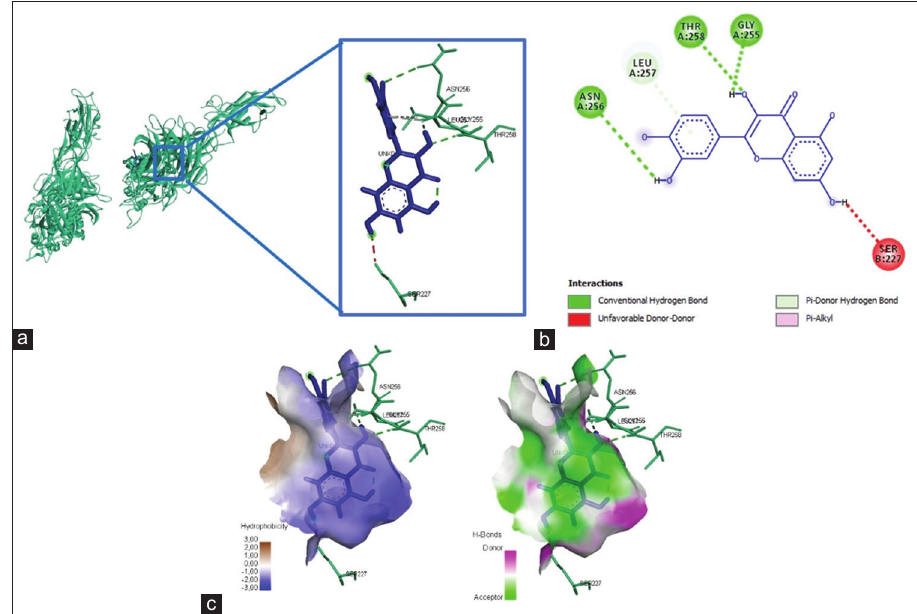
Figure-2: The three-dimensional and two-dimensional structure of the interaction between flavonoid compounds (quercetin) and α 5 β 1 integrins. (a) Three-dimensional structural interaction between flavonoid-ligand compound quercetin (blue) against integrin α 5 β 1 on the active binding site (green). (b) This interaction is built by hydrogen and carbon- hydrogen bonds on the active site of the α 5 β 1 integrin, namely, Thr258, Gly255, Asn256, Leu257, and Ser277, which can be seen in the two-dimensional (b) and three-dimensional (c)